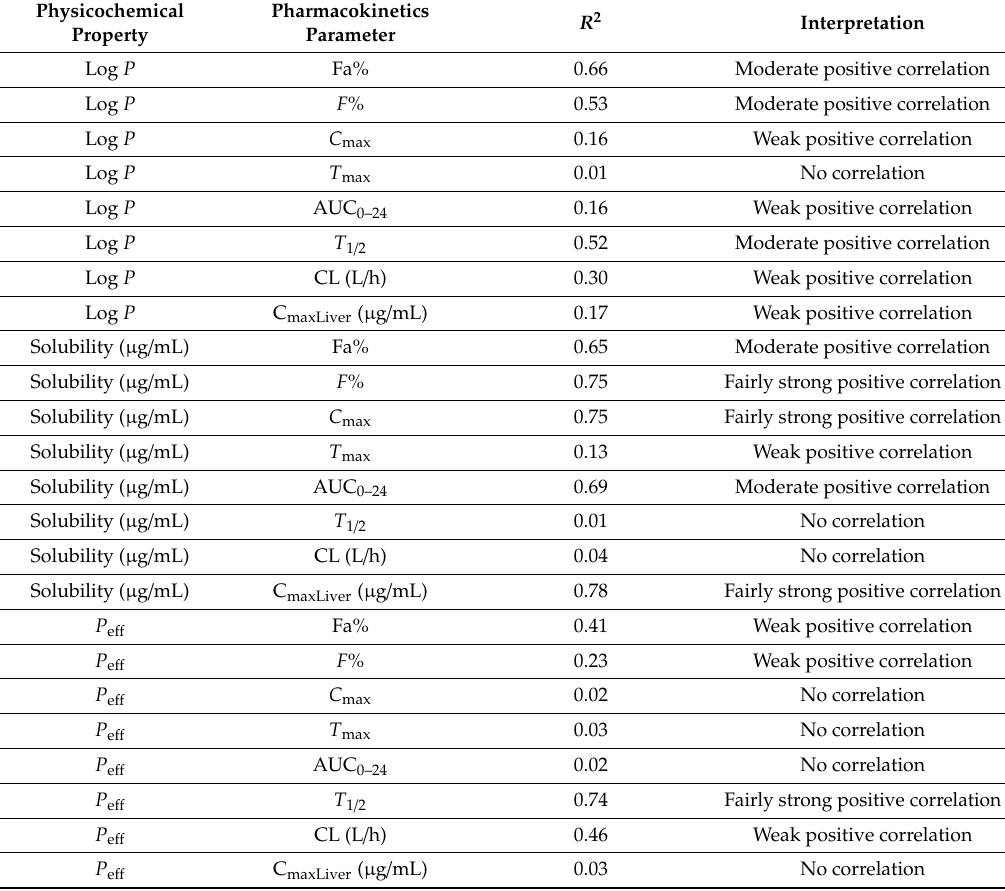
Table 4. Correlation of predicted physicochemical properties and pharmacokinetic parameters. Scales